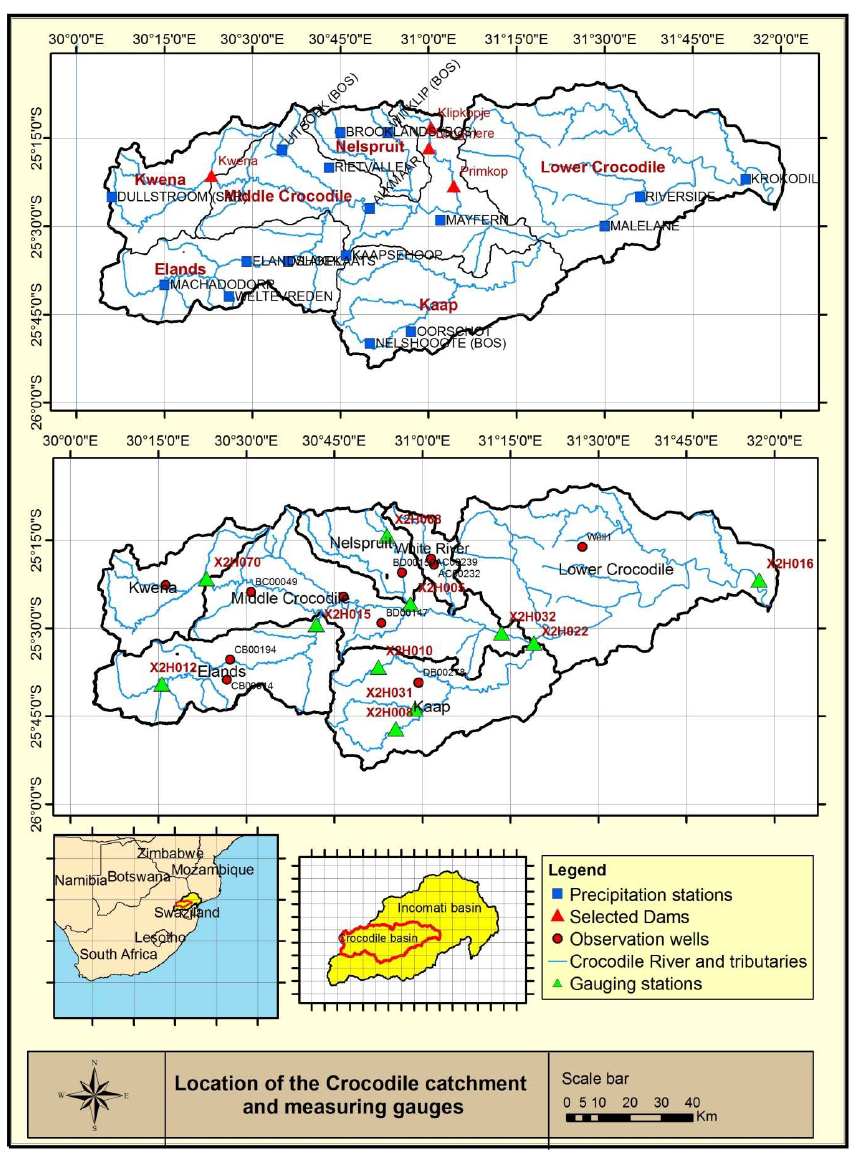
Figure 1. Location of precipitation gauges, discharge stations, observation boreholes and catchment division in sub-catchments.